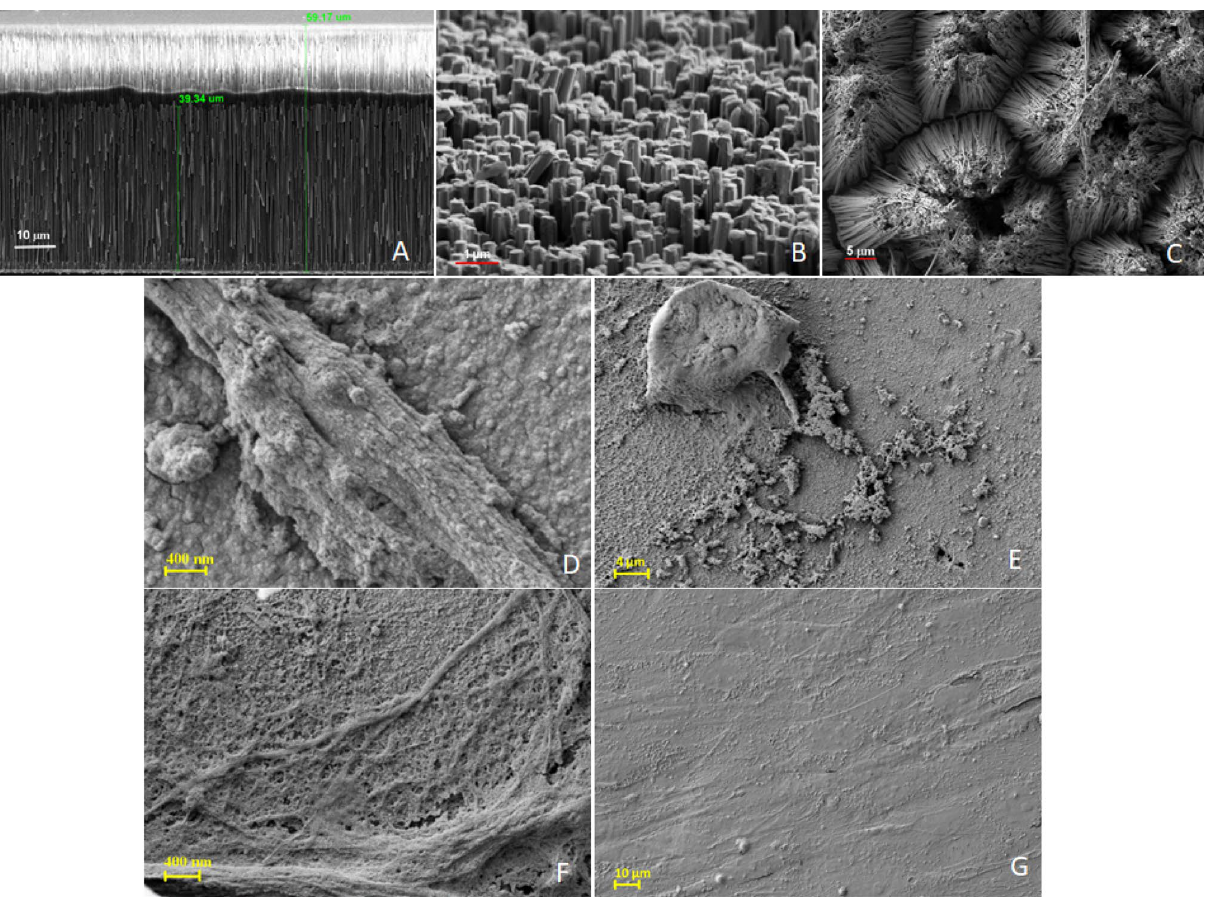
Figure 1. Scanning electron microscope (SEM) images of Ni NW: ( A ) 40 μm long NW deposed in a membrane of about 60 μm thickness; ( B ) surface of the partial dissolved membrane showing irregular NW tips; ( C ) groups of nanowires tips after dissolving completely the alumina membrane: ADSC on NW substrates ( D , E ) ADSC on NW placed in adherent cell culture plates are rounded or tubular with ruffled membranes; ( F , G ) ADSC cultured in ultralow adherent plates (ULA plates). Cells maintain characteristic fibroblastic morphology without apparent breach of cellular membrane however lower density and ruffled membrane features can be observed in ADSCs on adherent